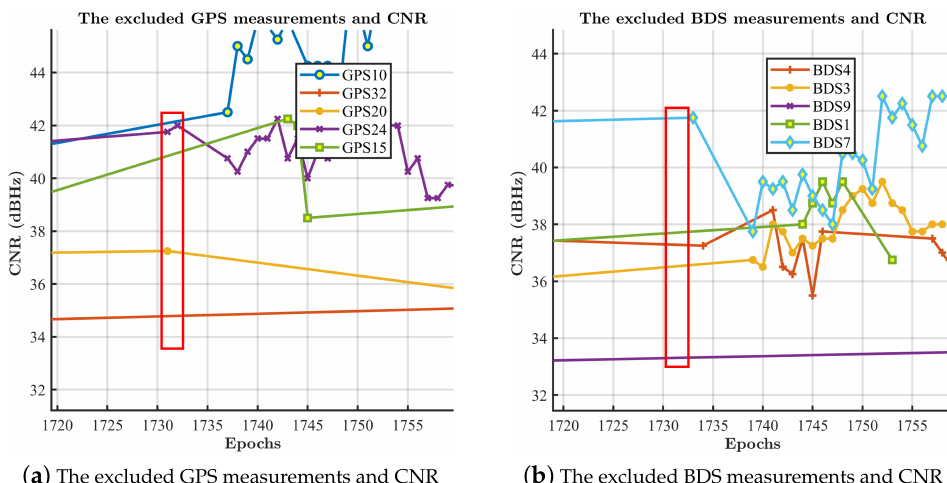
Figure 14. The excluded pseudo-range measurements and the corresponding CNR in